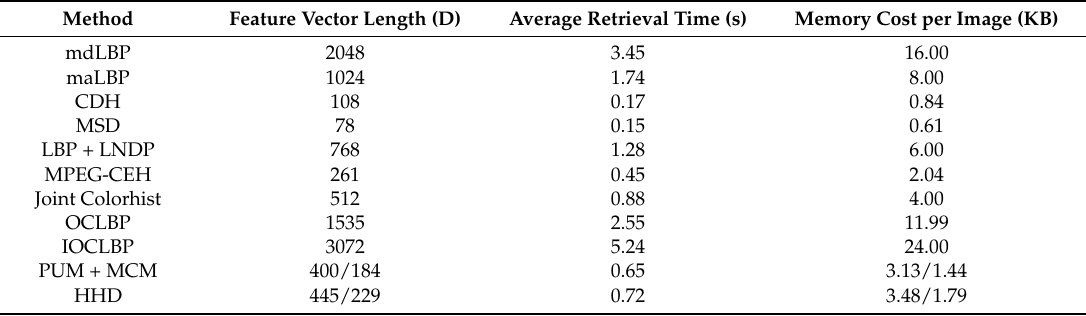
Table 9. Feature vector length (D), average retrieval time (s) and memory cost per image (KB) of different